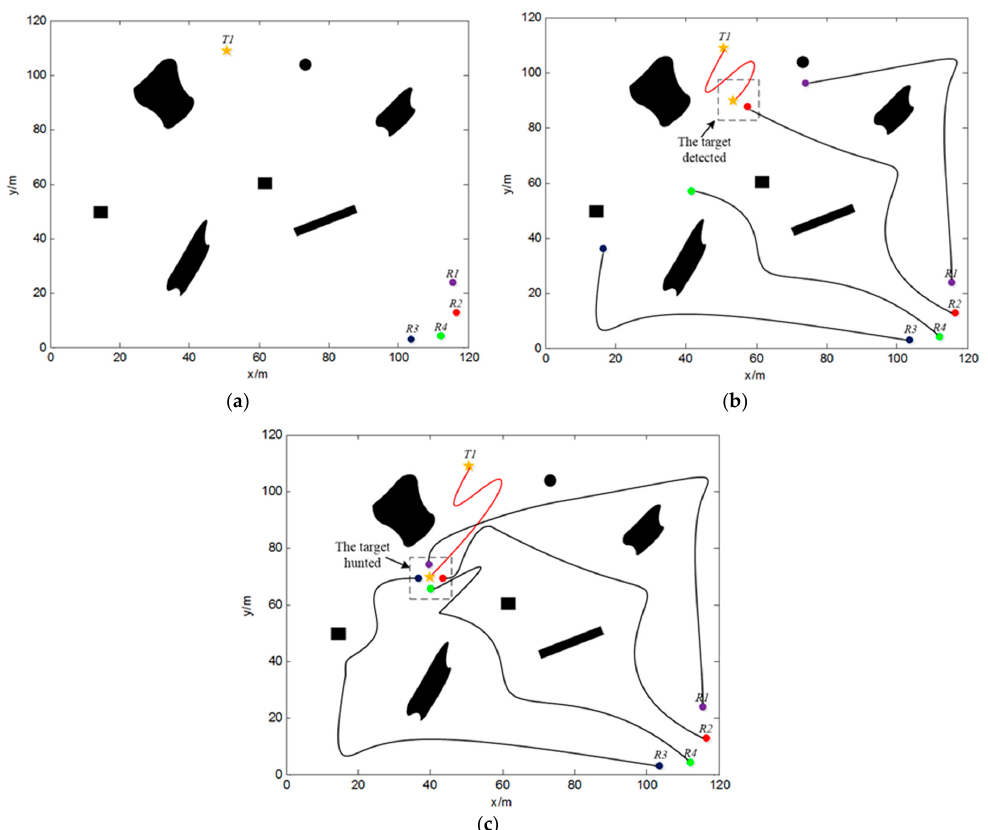
Figure 3. Simulation of hunting process with one target. ( a ) The initial state; ( b ) AUVs’ search trajectory for the target; ( c ) Final trajectories of the AUVs.